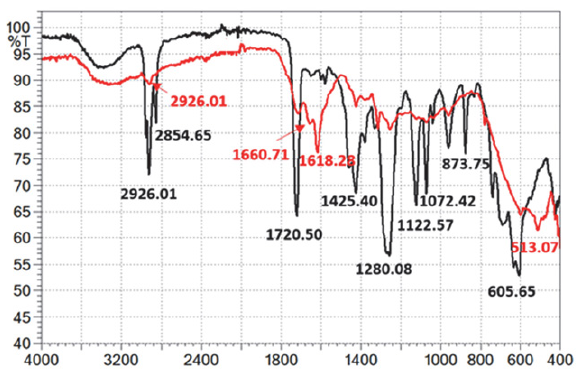
Figure 7. FTIR spectra at the front side of the new plasticized mem- branes (black line) and aged membranes (red line) operating in at- tenuated total reflection (ATR) mode.